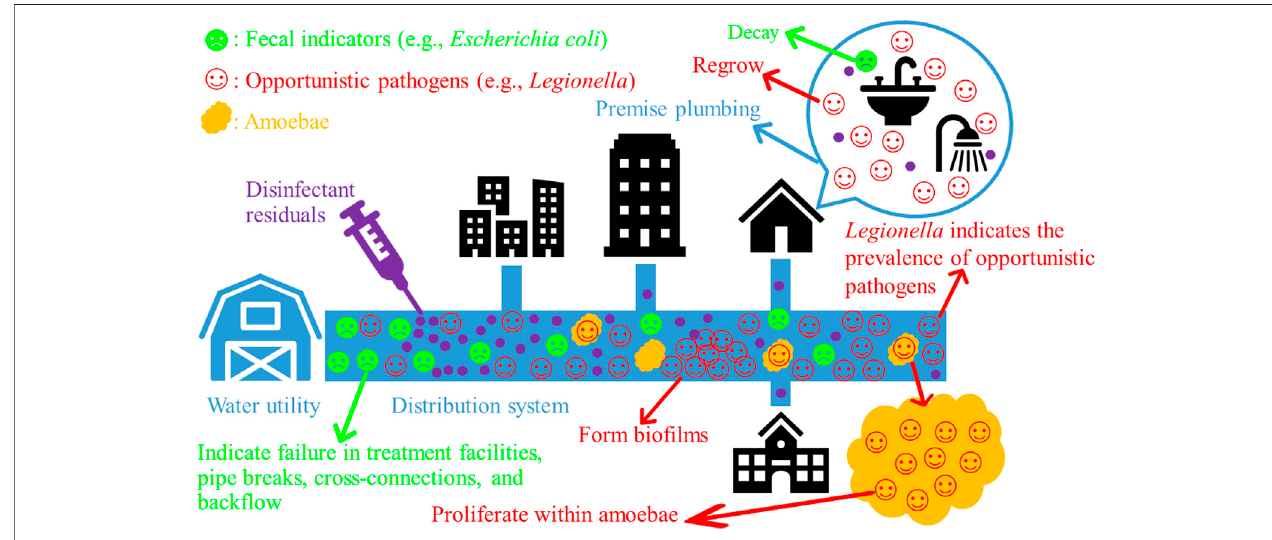
FIGURE 1 | The decay of conventional fecal indicators and the (re)growth of opportunistic pathogens (OPs) along municipal engineered water systems (EWSs). Bacterial OPs often proliferate within their amoeba hosts and form bio fi lms in EWSs. Drawn using PowerPoint (version 2102, Microsoft Of fi ce Professional Plus 2019) (Microsoft Corporation, Redmond, Washington,